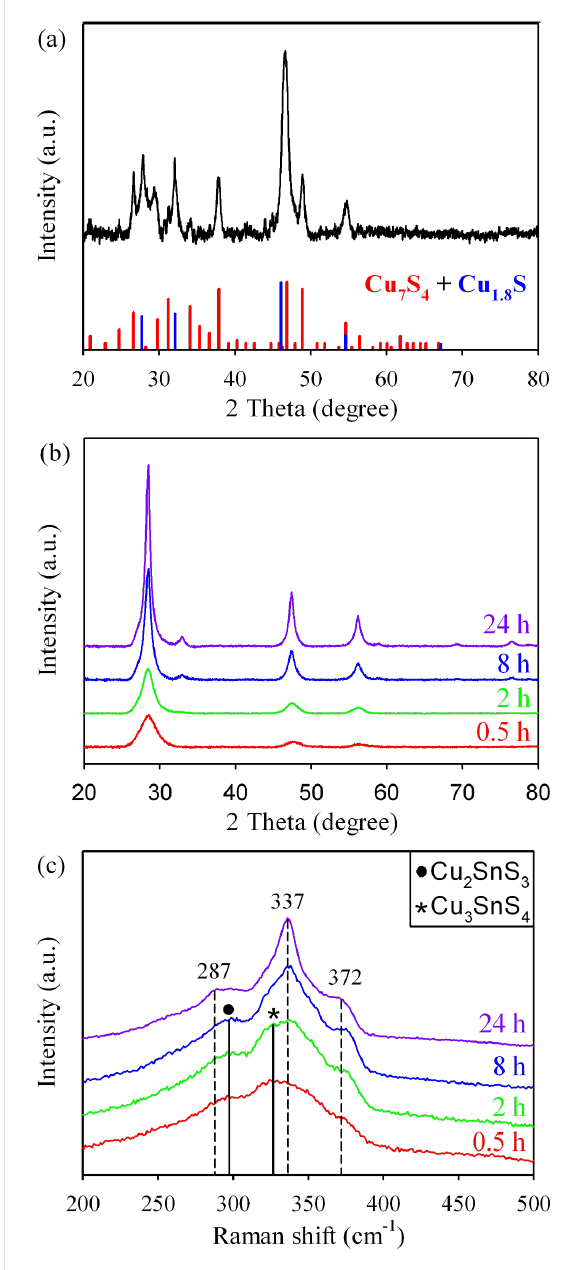
Figure 5: (a) XRD of the precipitate collected from the precursor solution prior to hydrothermal reaction and (b) XRD patterns and (c) Raman spectra of the samples synthesized at different reaction